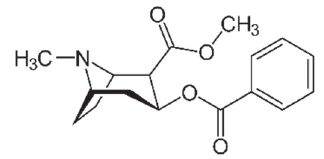
Figure 10. Chemical structure of DHEA. Formula: C 19 H 28 O 2. Physiological effect: Androgen [18]. Provides a significant, continuous, cumulative and lasting physical advantage in sports competitions by creating larger and stronger bones, greater muscle mass and strength, and increased circulating hemoglobin. • Fighters involved in doping with dehydroepiandrosterone (DHEA) 1.